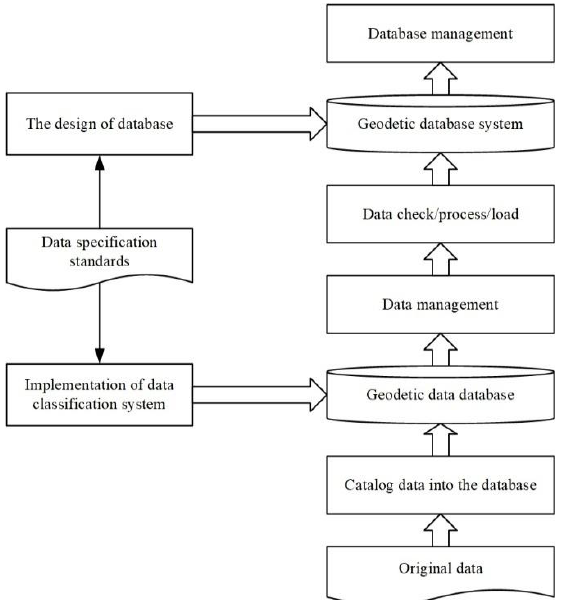
Figure 3, Geodetic Database